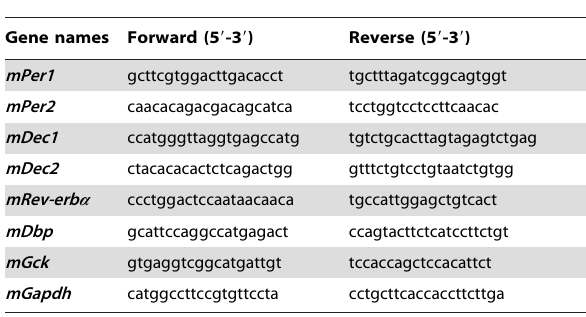
Table 1. Primer pairs used for real-time